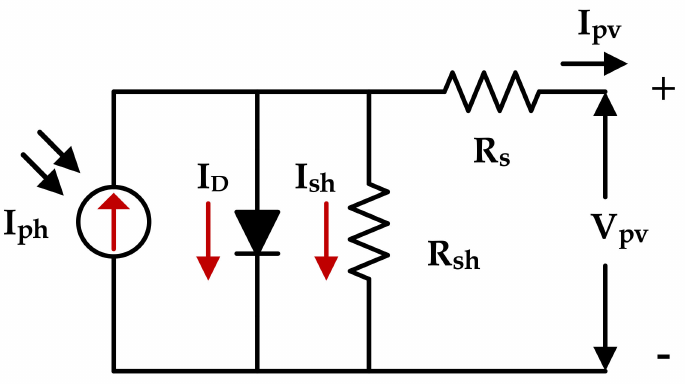
Figure 2. The single-diode PV model.